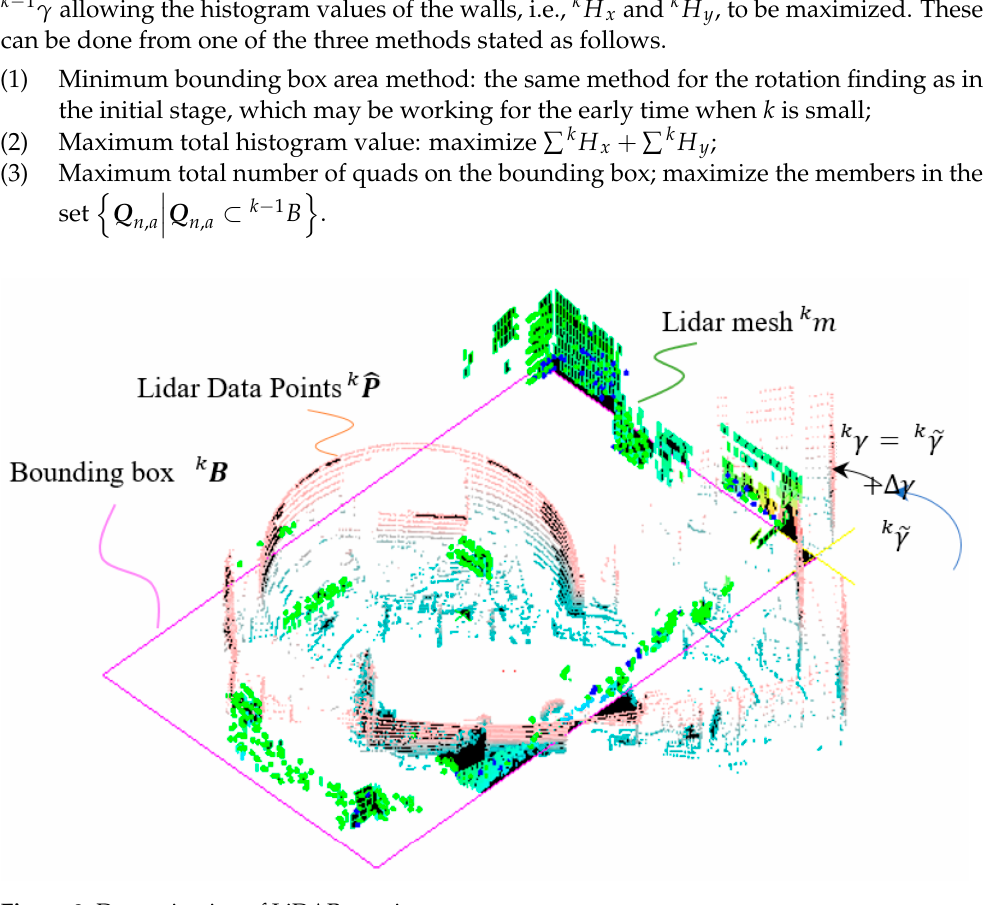
Figure 8. Determination of LiDAR